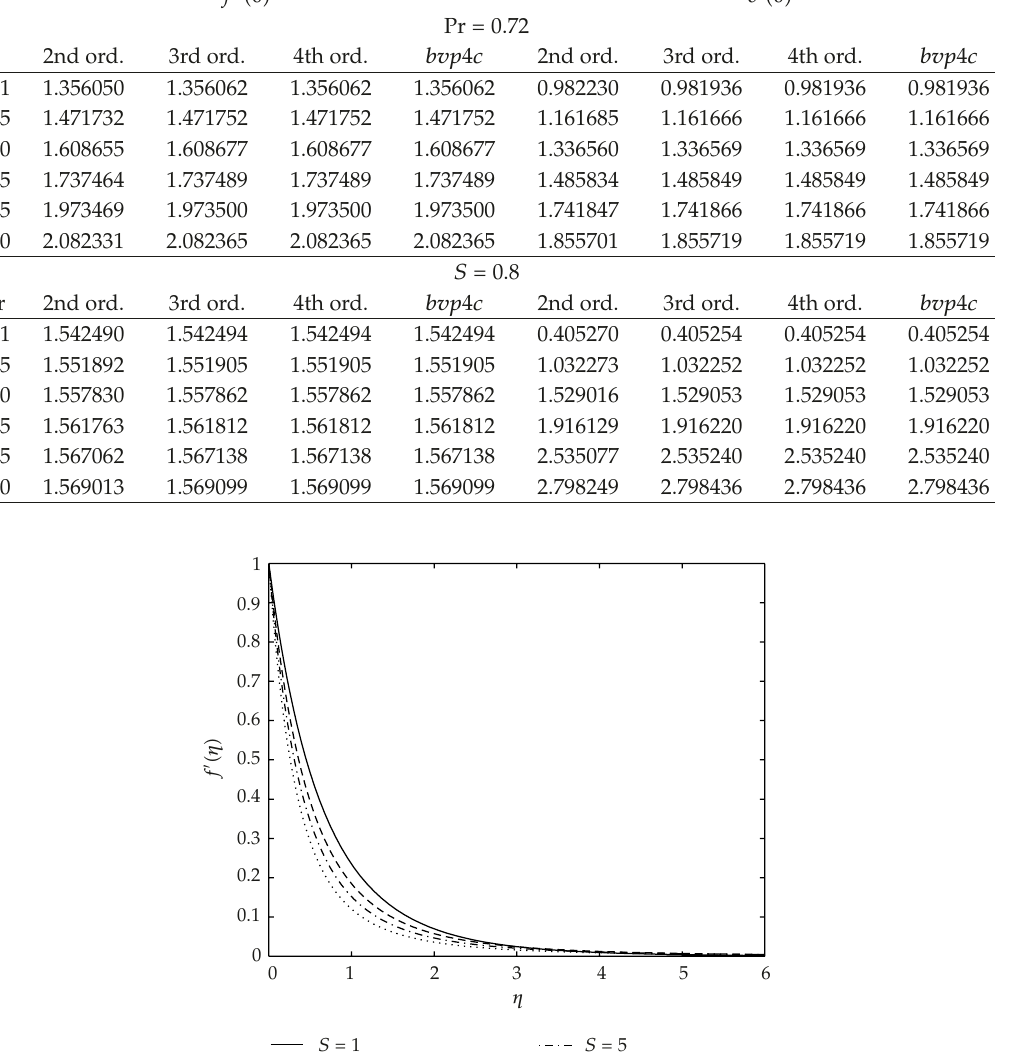
Table 3: Comparison between the present successive linearisation method (cid:6) SLM (cid:7) results and the bvp4c numerical results for − f (cid:6)(cid:6) (cid:6) 0 (cid:7) and − θ (cid:6) 0 (cid:7) for various values of S and Pr when β 1 (cid:5) 0 . 1 ,β 2 (cid:5) 0 . 1 ,M (cid:5) 1; m (cid:5) 1; S (cid:5) 0 . 8.